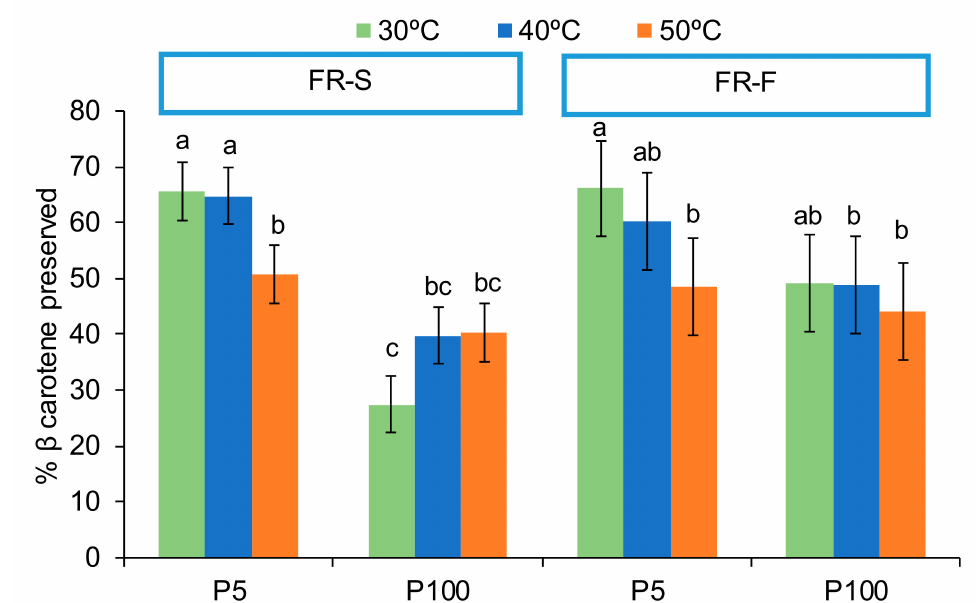
Figure 6. Percentage (%) of preserved β -carotene (mean and Tukey’s HSD) according to the interaction between shelf temperature (30, 40 or 50 ◦ C) and pressure (P 5 : 5 Pa and P 100 : 100 Pa) factors for each freezing-rate(FR-SandFR-F:slowandfastfreezingrates, respectively). Di ff erentlettersindicatedi ff erent homogeneous groups for the temperature*pressure interaction for both freezing-rate independently ( p <